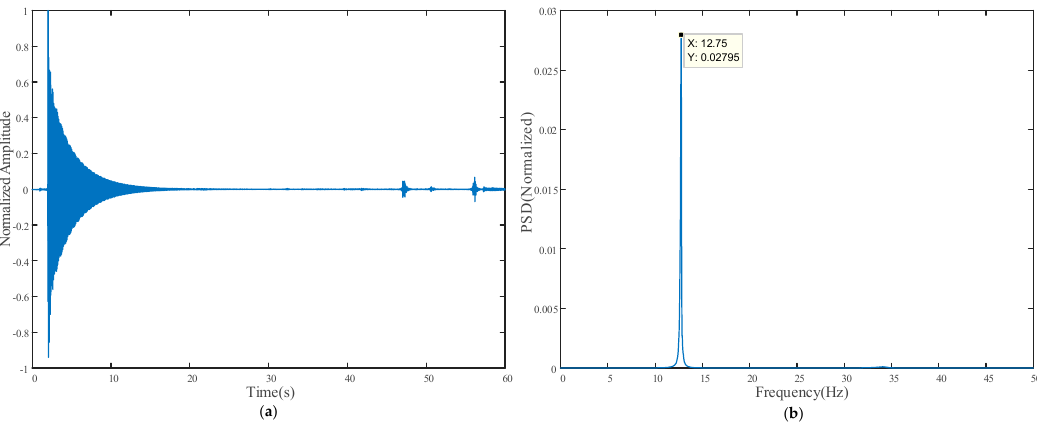
Figure 12. Vibrometer laboratory experimental result: ( a ) Time history of normalized acceleration signal; ( b ) Normalized power spectrum density.